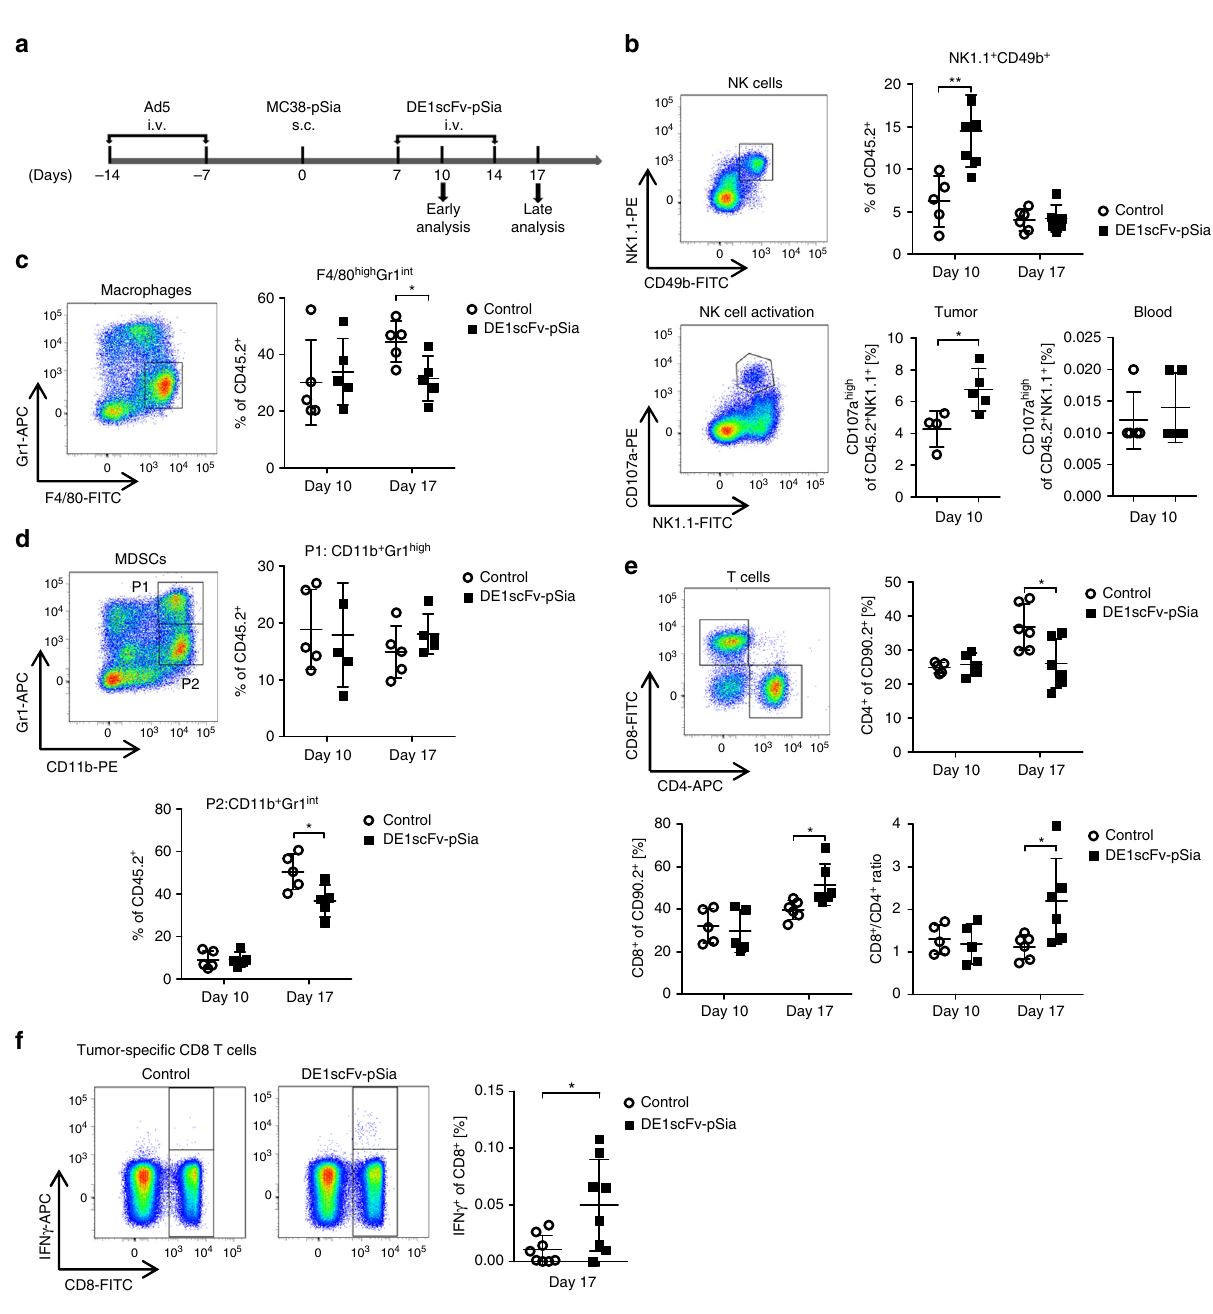
Fig. 3 Ab-retargeting reduces intratumor myeloid cells and supports NK cell and CD8 T-cell in fi ltration. a MC38-pSia cells were used to establish s.c. tumors in Ad5-vaccinated mice. Tumor-bearing mice received i.v. injections of DE1scFv-pSia or saline, and were sacri fi ced according to the shown schedule. Tumor tissue was examined for in fi ltration of different leukocyte subsets via fl ow cytometry. b Frequencies of NK cells (NK1.1 + CD49b + ) were calculated as percentage of CD45.2 + leukocytes. NK cell activation was determined by surface expression of CD107a. Macrophages (Gr1 + F4/80 high ) and different fractions of myeloid-derived suppressor cells (MDSCs; P1: CD11b + Gr1 high ; P2: CD11b + Gr1 int ) are shown in c and d , respectively. Group size was in general n = 5 with following exceptions: n = 7 (NK cells/day 10/DE1scFv-pSia); n = 6 (NK cells/day 17/control and DE1scFv-pSia groups); n =